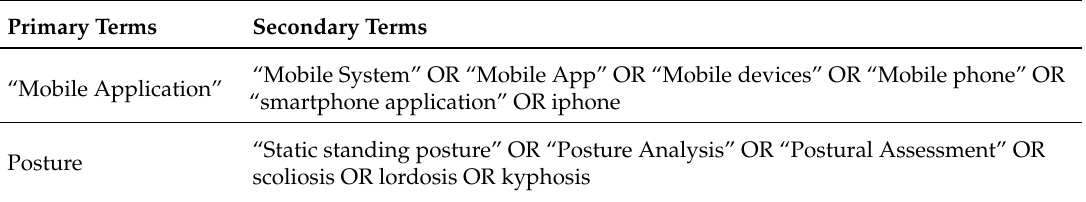
Table 5. Terms used in the search